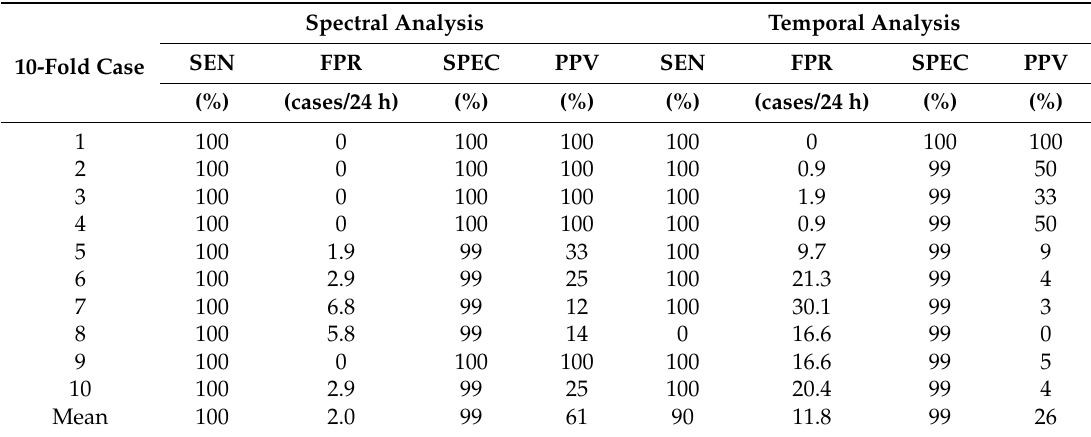
Table 2. Seizure detection via spectral and temporal methods.